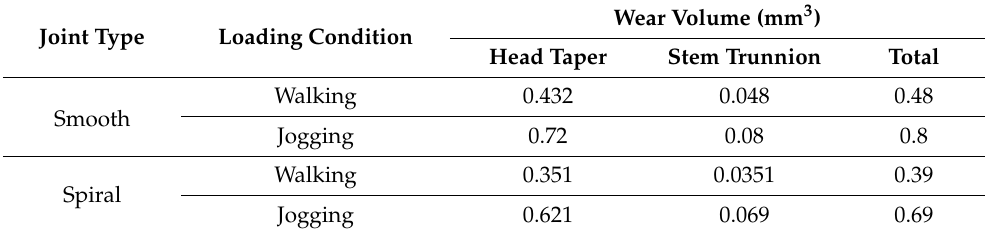
Table 4. Wear rate on head taper and stem trunnion contact